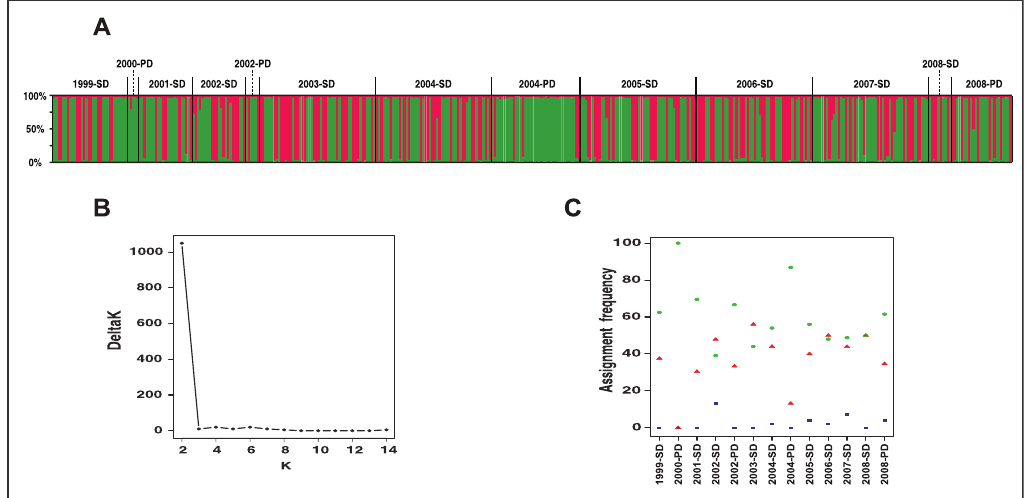
Figure 3. Genetic clustering of ten successive cohorts of M.schimitscheki (1999–2008). This Bayesian analysis implemented in STRUCTURE used a model allowing admixture and assumed two population clusters (K=2). A: Graphical representation of the two genetic clusters, where each vertical line represents an individual and each color represents a cluster. Individuals are grouped by year of cohort production and diapause phenotype (SD=2-year diapause, PD=4-year prolonged diapause). B: Curve of Evanno’s DeltaK corresponding to the STRUCTURE simulations. C: Assignment frequencies of individuals to each cluster in each group (in green and red according to the colors of Figure 3a). Frequencies of admixed individuals are in blue.